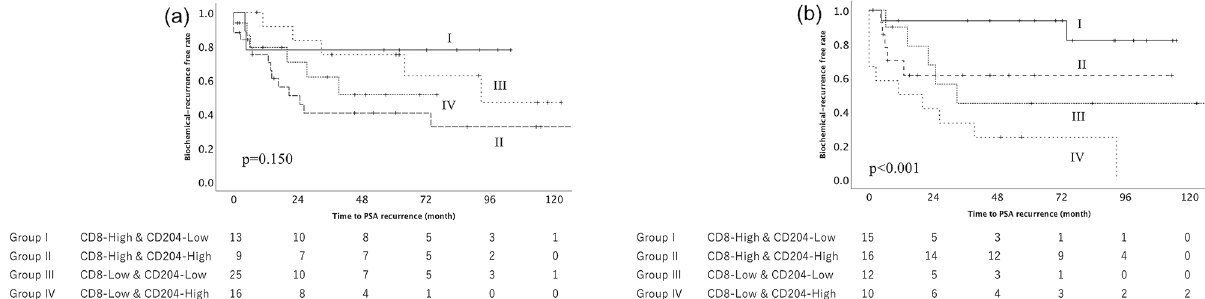
Figure 2. The Kaplan–Meier analysis of the recurrence-free survival of patients with seminal vesicle invasion according to the combination of the CD8 + and CD204 + cell. No significant difference between four groups was observed in the main tumor area (a, p = 0.150). However, a significant difference between four groups was observed in the seminal vesicle invasion area (b, p < 0.001). Group II, which included patients with the higher CD8 + cell count and the lower CD204 + cell count, had the most favorable outcome among the four groups. The 6-year progression free survival (PFS) rate of Group II was